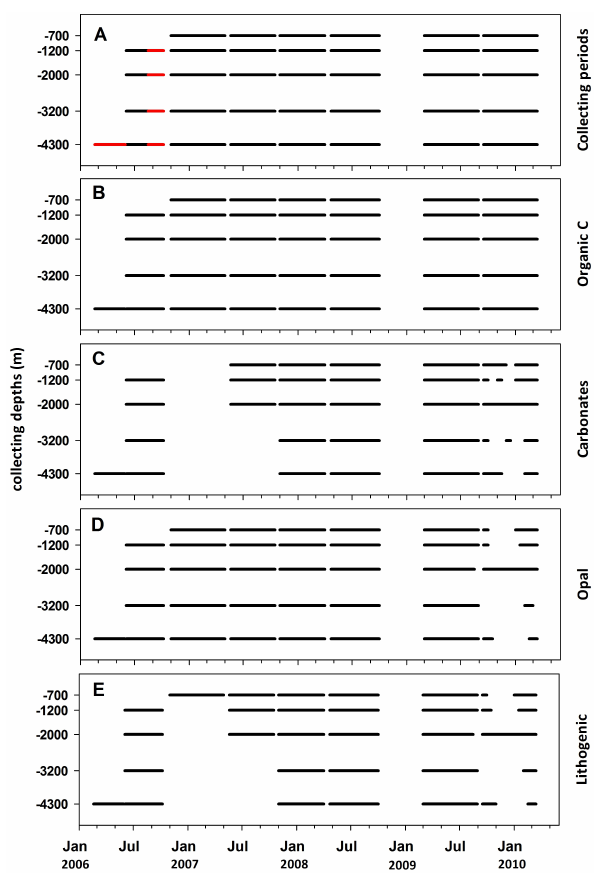
Fig. 2. (A) Duration, time and depth coverage of NESTOR trap sampling. The red lines indicate one-week sampling intervals, the black lines two-week sampling intervals; (B, C, D, E) time slots for organic carbon, carbonates, opal and lithogenic material, respec- tively, analyzed in this